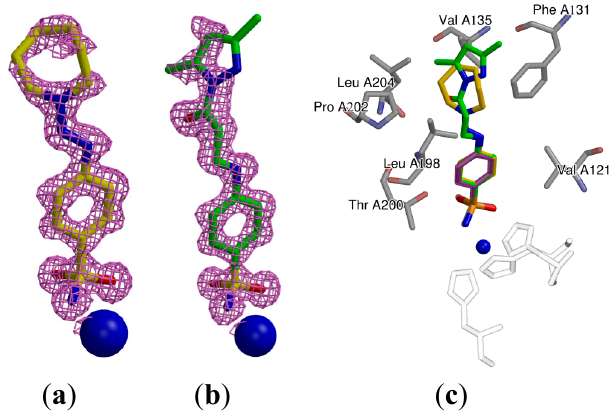
Figure 3. The view of the electron density of the compounds 31 ( a ) and 18 ( b ) located in the active center of CA II as determined by X-ray crystallography. The catalytic Zn(II) atoms are shown as blue spheres. The electron density difference maps are contoured at 2.5 σ ; ( c ) The superposition of 18 (green), 31 (yellow) and benzenesulfonamide (magenta) from the crystal structure PDB ID 2WEJ [39] bound in the active site of CA II show the identical orientation of the benzene ring. The active site residues of CA II are shown in grey while the histidine residues holding the zinc atom are transparent.